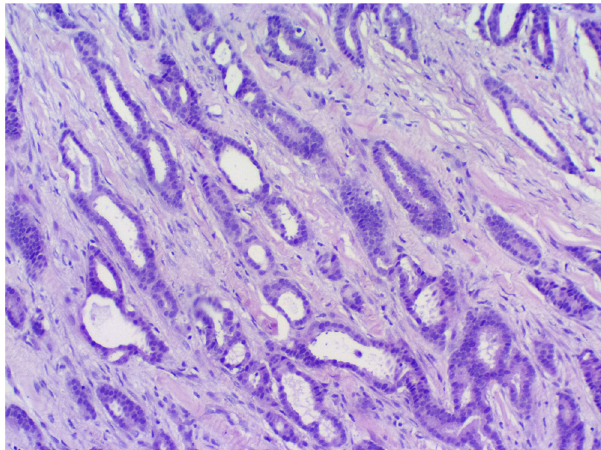
Figure 3. Breast infiltrating duct carcinoma (H&E stain, X200 magnification).